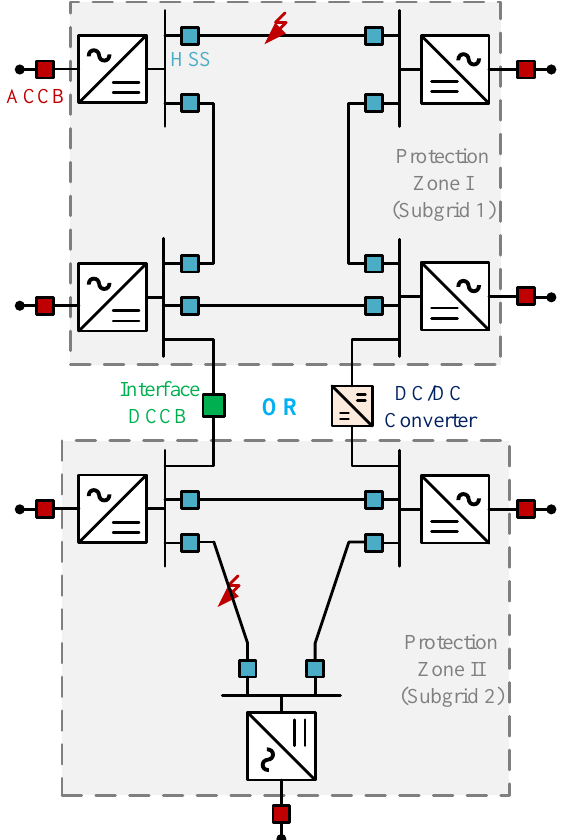
Figure 6. Protection zones with a partially-selective fault clearing strategy. DCCBs are the major components of fully-selective fault clearing strategies.